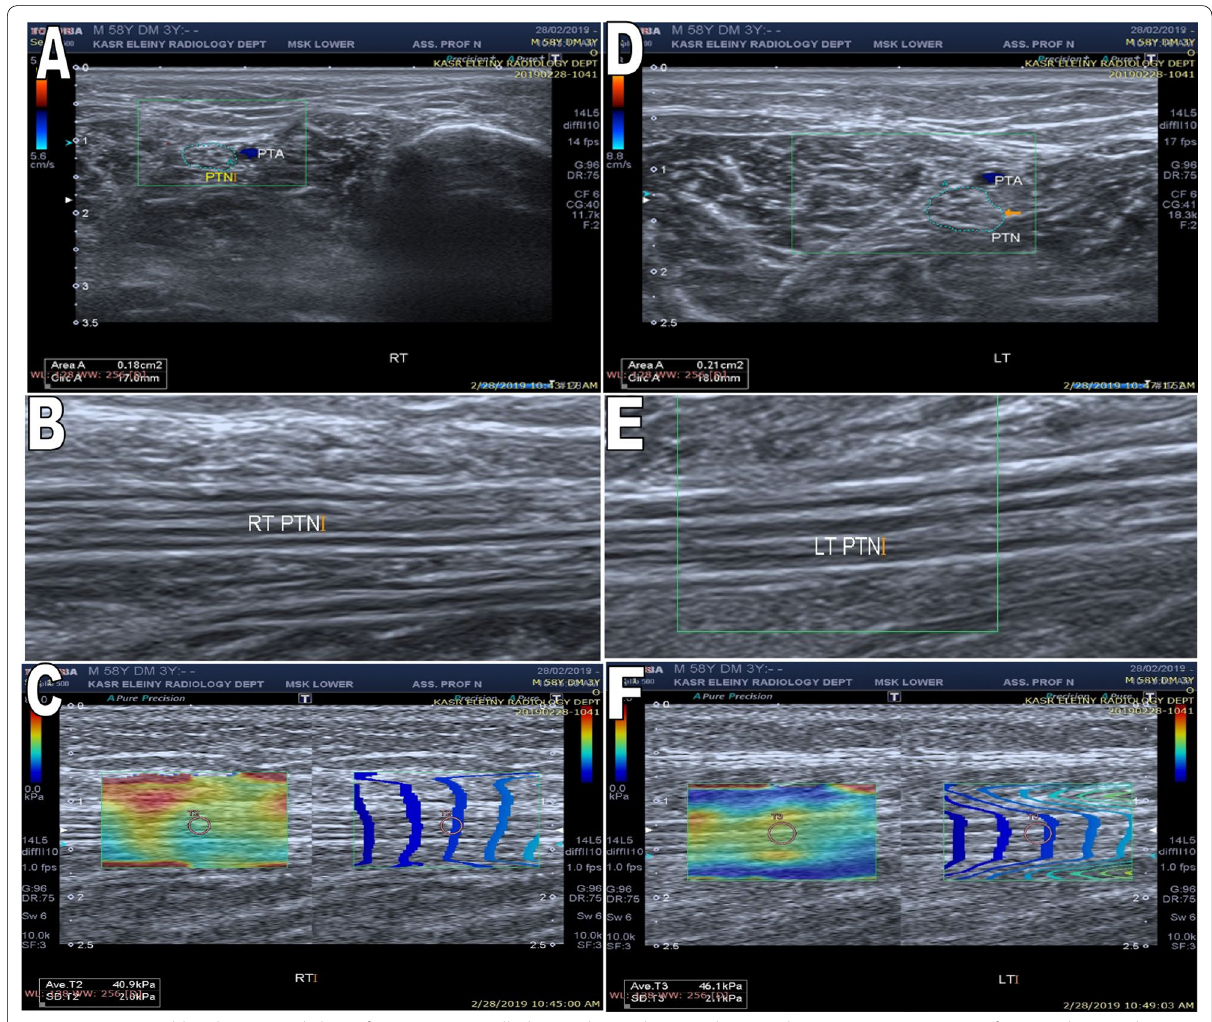
Fig. 3 A 58-year-old male patient diabetic for 2 years controlled on oral anti-glycemic drugs, with no signs or symptoms of DPN with normal nerve conduction study. A The right PTN in relation to the PTA with its CSA measuring 18 mm 2 . B B-mode image shows the longitudinal axis of the right PTN. C The right image is the B-mode, the left image measures the elasticity of the PTN (40.9 kPa) with a color-coded box, circular ROI (T2) for quantitative measurements, and a color code scale at the top side of the image. D The left PTN in relation to the PTA with its CSA measuring 21 mm 2 . E B-mode image shows the longitudinal axis of the left PTN. F The right image is the B-mode, the left image measures the elasticity of the PTN (46.1 kPa) with a color-coded box, circular ROI (T3) for quantitative measurements, and a color code scale at the top side of the image. There is a mild increase in the CSA and nerve stiffness of both tibial nerves; however, the patient has no clinical or neuro-electrical signs of DPN denoting that SWE can estimate the state of the neuropathy even whenever ever it is still